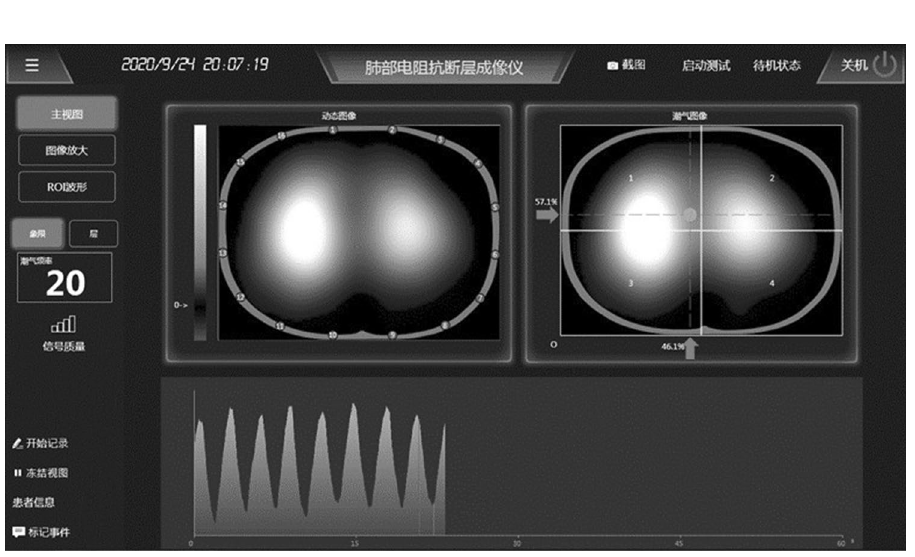
Figure 2. Screenshot of the software